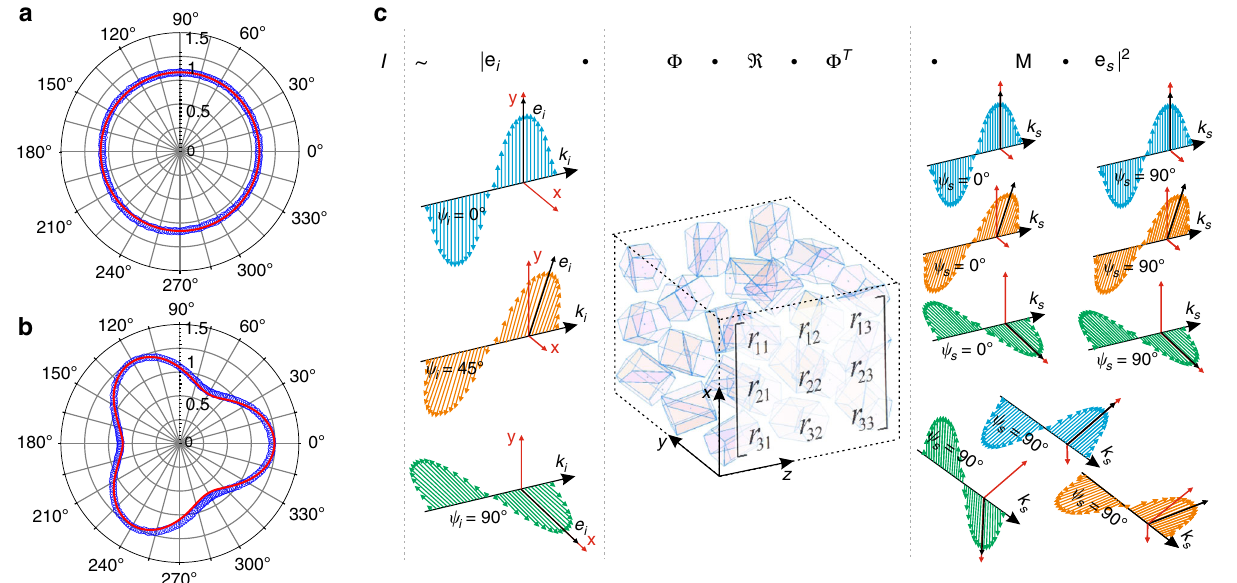
Fig. 1 Optimization of the polarized Raman signal collection geometry. Comparison between theoretical (red line) and experimental (blue circles) responses of the sum of Si modes versus wafer rotation angle ψ plotted in polar coordinates for Si wafer with surface plane (111) for on-axis ( a ) and off-axis ( b ) polarized Raman scattering channels ( c ), illustration of the incident/scattering polarization and signal collection geometries for a solution with nine polarized channels.